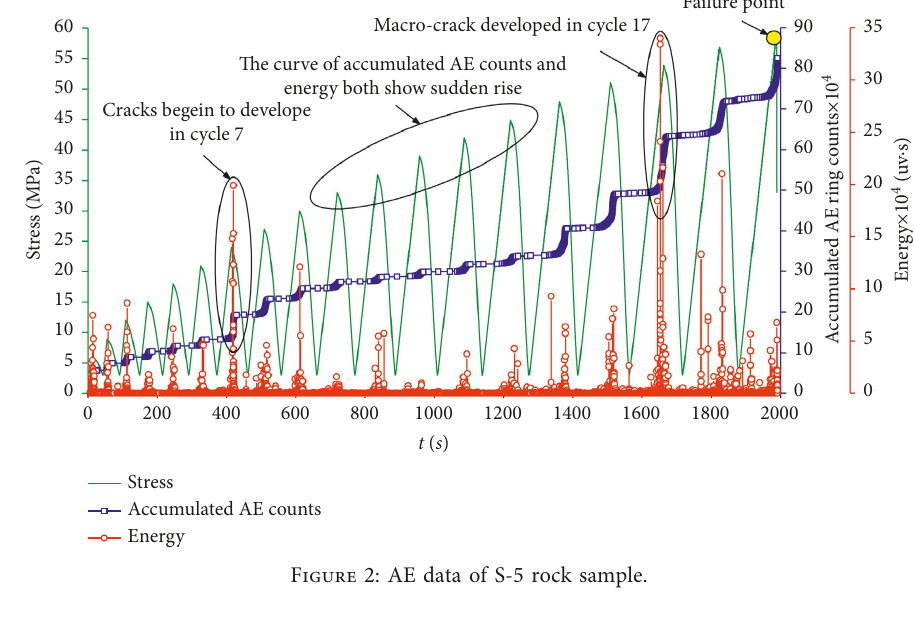
Figure 2: AE data of S-5 rock sample.